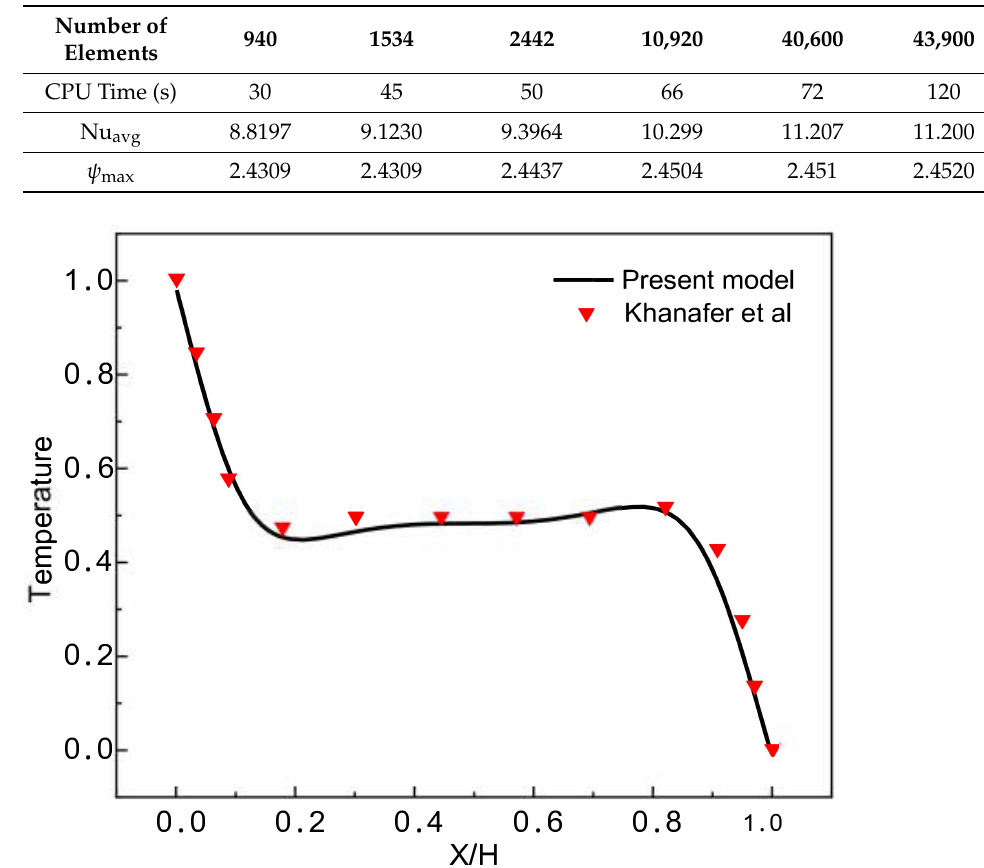
Figure 2. Dimensionless Temperature Distribution for (Ra = 10 5 and Pr = 0.7) [57]. Reprinted with permission from Elsevier (2003). Copyright